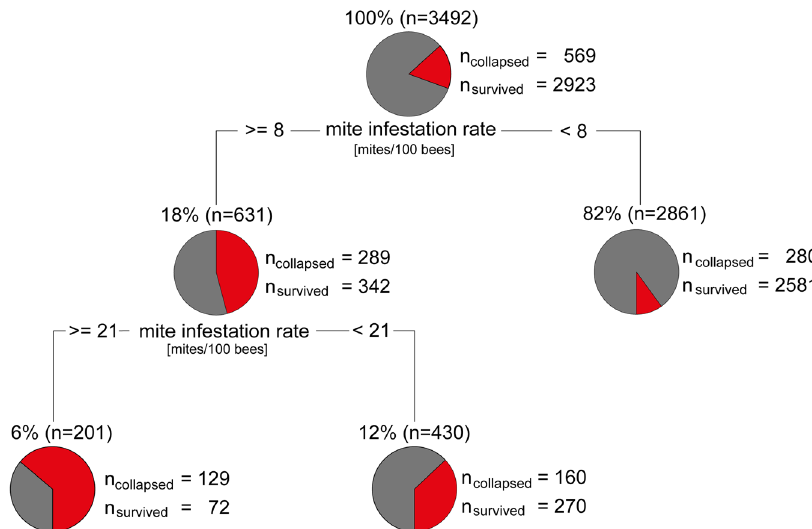
Fig. 2 Testing the relevance of the attributes “ mite infestation rate ” and “ Nosema infection status ” for honey bee colony mortality by classi fi cation tree analysis. The proportion of colonies represented by each circle (leaf/outcome) is shown above the respective circle. In each circle, the gray parts represent the proportions of overwintered (survived) colonies and the red parts the proportions of collapsed colonies. The number of the collapsed and survived colonies are given next to each circle. The tested attribute that resulted in each of the two nodes is given below the circles (mite infestation rate). Horizontal lines represent the branches/decisions and the numbers within these lines show the mite infestations rates that best splitted the data to obtain the next nodes or leafs. For classi fi cation tree analysis, the R packages rpart 81 and rattle 82 with standard settings were used.